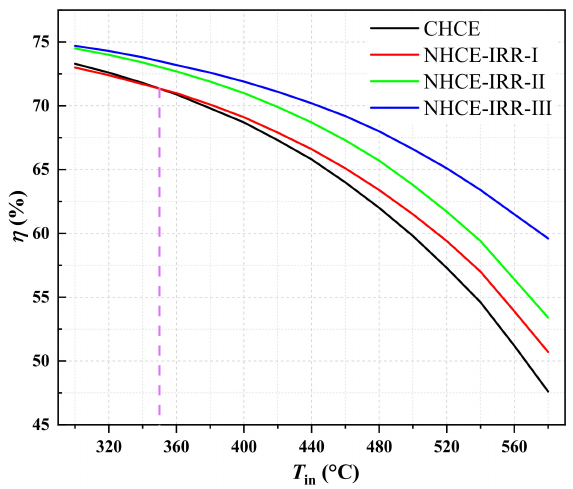
Figure 7. Energetic e ffi ciency of PTC system with di ff erent HCEs versus inlet